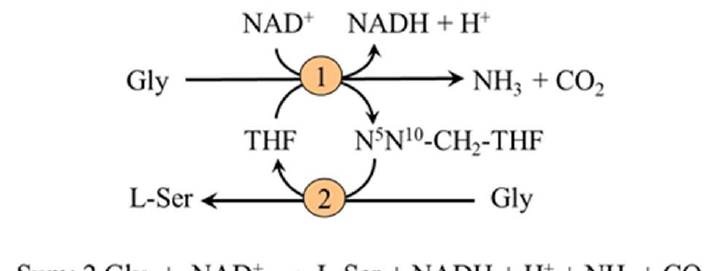
Figure 3. L-serine synthesis from glycine in the kidneys. 1, glycine cleavage enzyme; 2, serine hy- droxymethyltransferase .